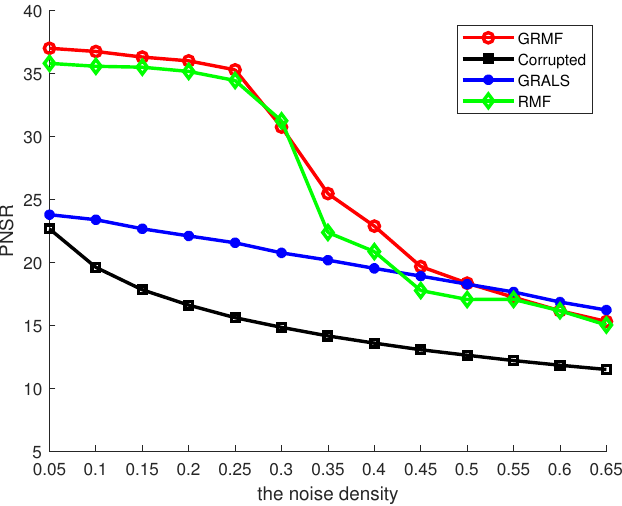
Figure 7. Evaluation of image recovery with Salt-and-pepper